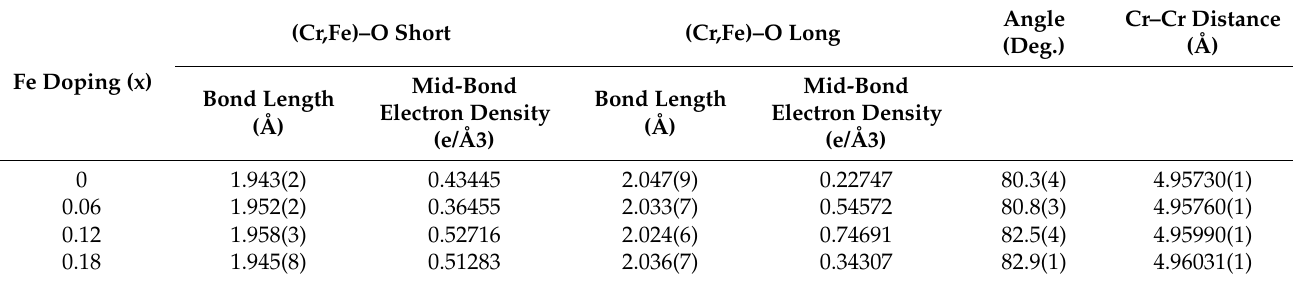
Table 1. The calculated bond lengths and mid-bond electron density for short and long Cr/Fe–O bonds along the (001) and (110) planes and the Cr–Cr distance in the (110) plane for the Cr 2 − x Fe x O 3 (0.0 ≤ x ≤ 0.18)